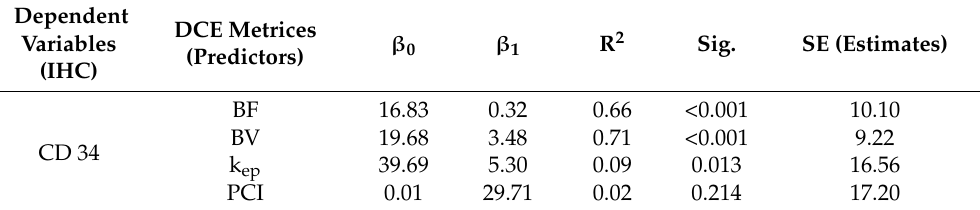
Table 7. Linear regression models ( n = 80) with angiogenesis (CD34) in the synovium and dynamic contrast enhance magnetic resonance imaging